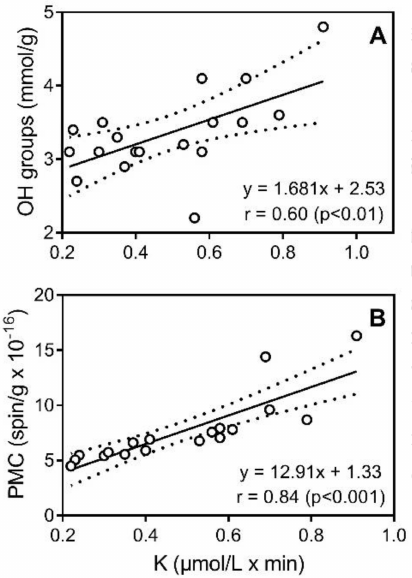
Figure 6. Plot of aromatic OH group content ( Panel A ) and number of paramagnetic centers (PMC) ( Panel B ) in the HA fractions versus antioxidant activity of the fractions in the electrochemical assay for all 18 HA fractions. Dashed lines indicate area of the 95% confidence